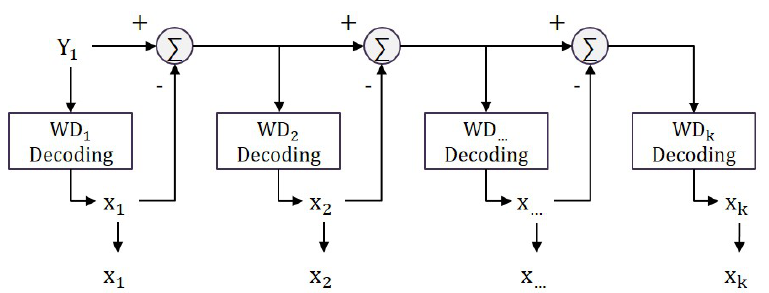
Figure 5. System model: